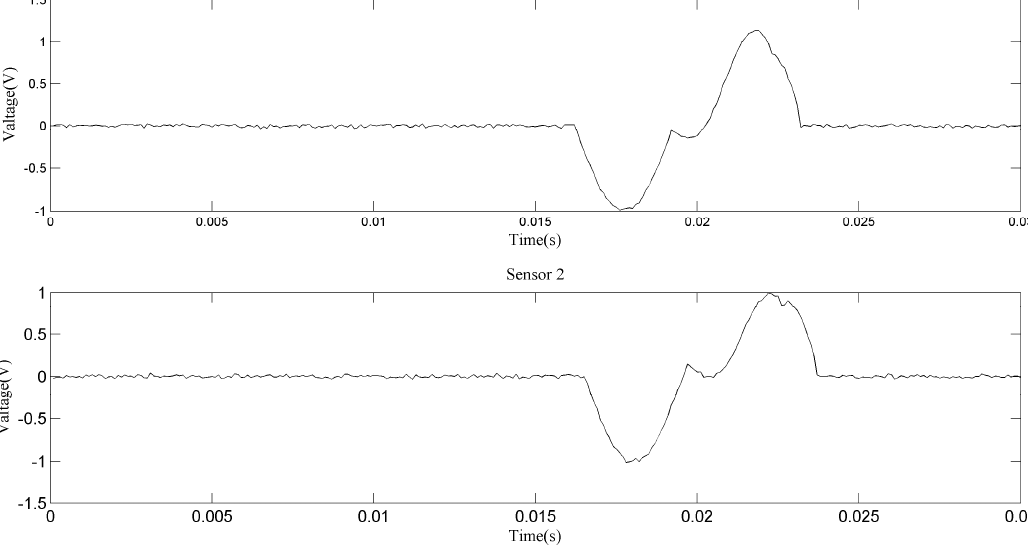
Figure 7. Aliasing signals of section a1.